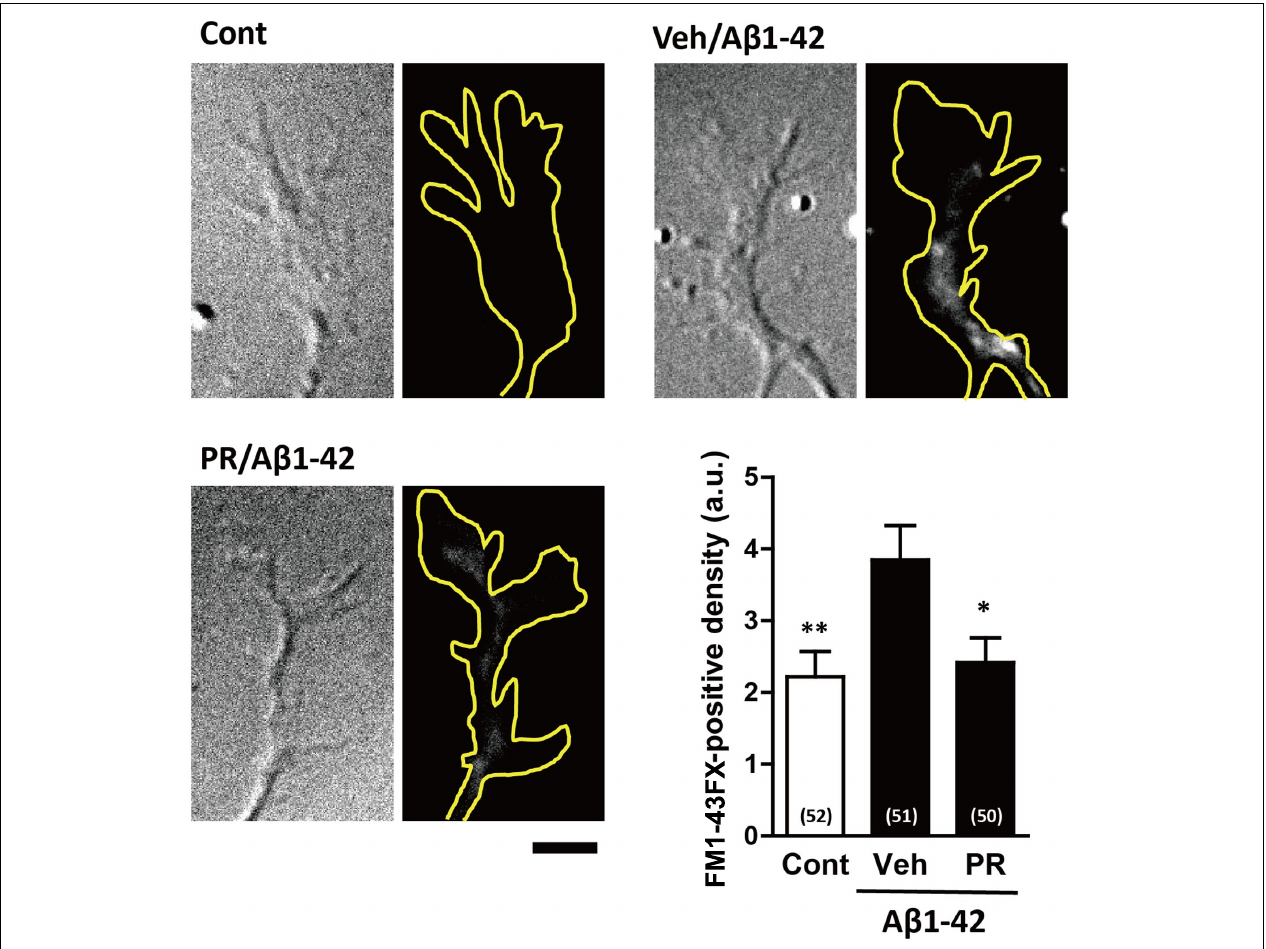
FIGURE 6 | Effects of Polygalae Radix (PR) extract on amyloid β (A β )-induced endocytosis. Cortical neurons were cultured for 3 days, and treated with vehicle solution (Cont) or A β 1–42 (1 µ M) for 30 min. Next, they were treated with FM1-43FX (20 µ M) for 1 min, and vehicle solution (Cont, Veh) or PR extract (100 µ g ml − 1 ) for 20 min, before the neurons were fixed. Representative differential interference contrast and fluorescence images are shown. The yellow dotted lines represent outlines of the growth cone. Scale bar, 5 µ m. The density of FM1-43FX-positive area in each growth cone were quantified. The mean values of the data are presented together with the standard error. The numbers in parentheses indicate the measured numbers of growth cones. ∗ P < 0.05, ∗∗ P < 0.01 vs. Veh/A β 1–42; Bonferroni’s multiple comparison